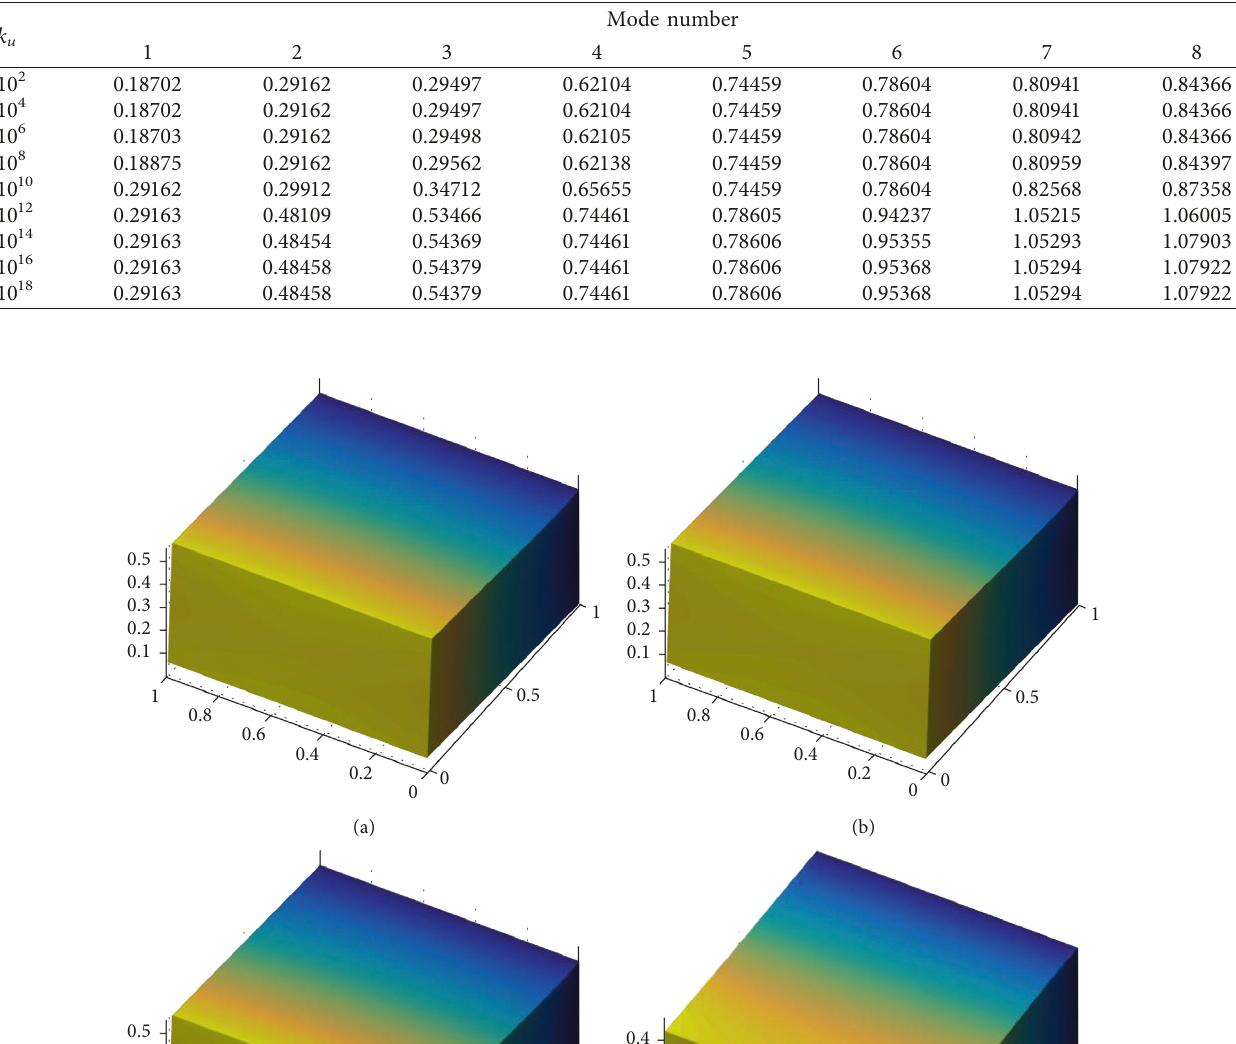
� 10 2 ; (b) k � 10 6 ; (c) k � 10 10 ; u u u